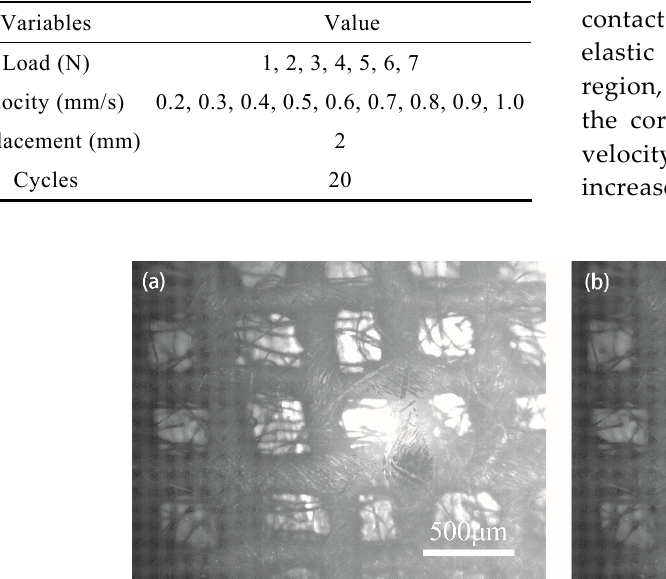
Table 1 Details of the experimental parameters.